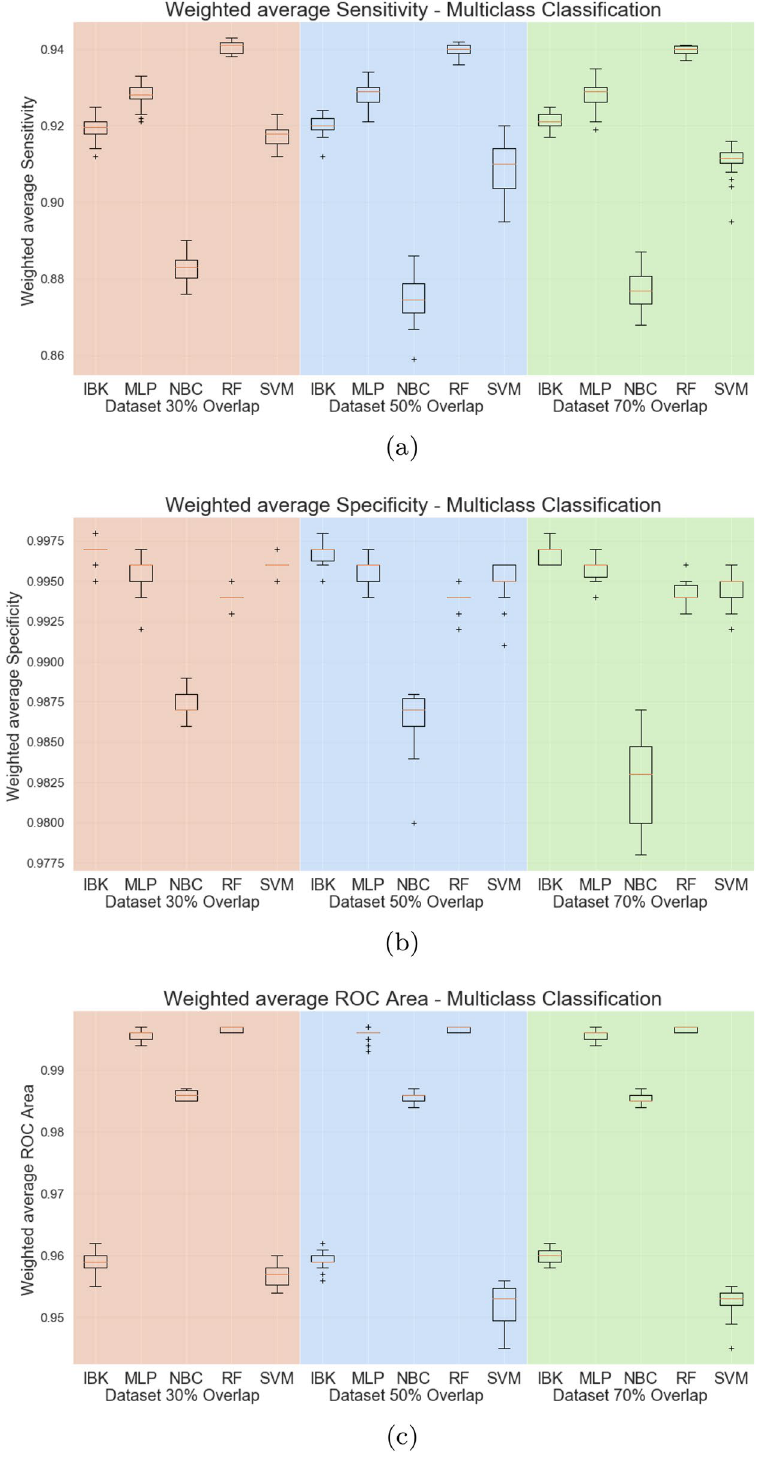
Figure 6. Weighted average sensitivity ( a ), specificity ( b ), and ROC area for Multiclass test